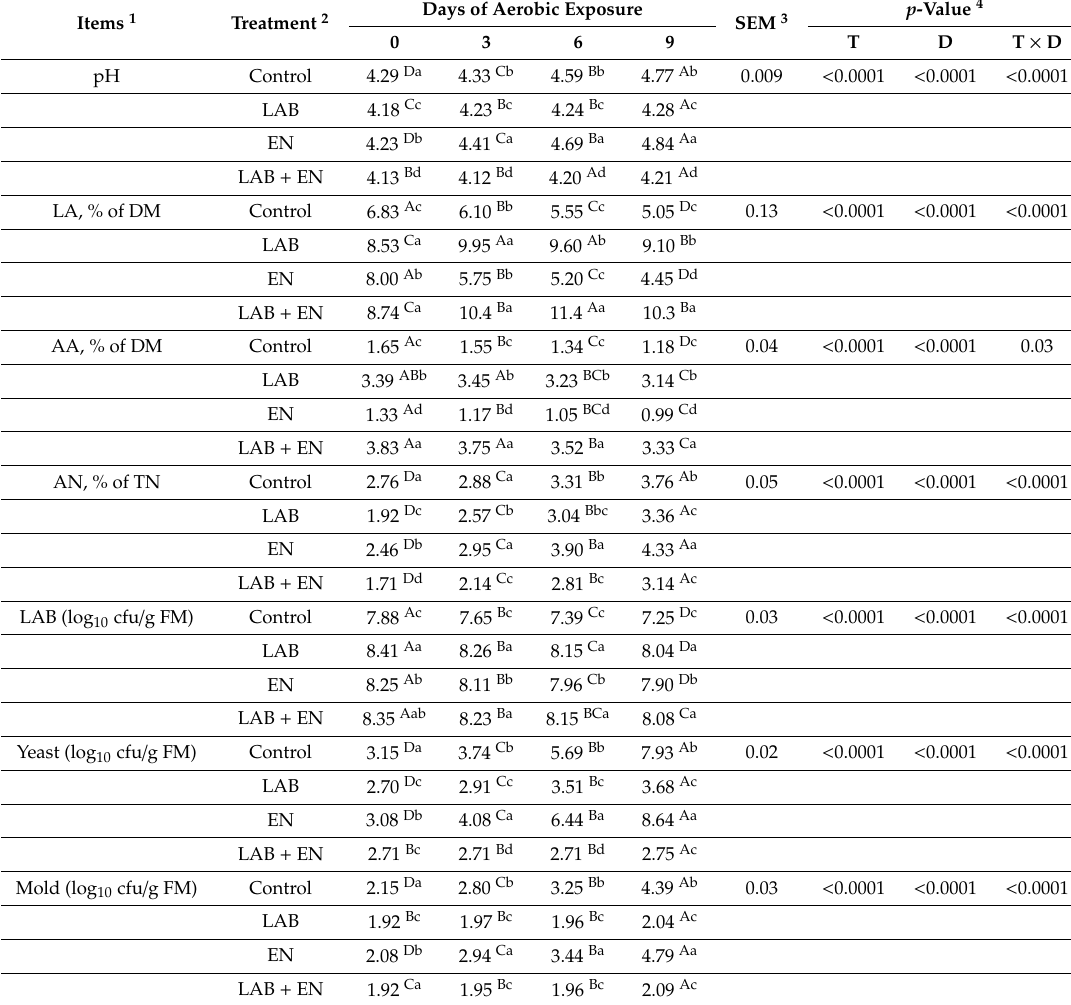
Table 5. E ff ects of lactic acid bacteria and / or fibrolytic enzyme on the fermentative characteristics of the total mixed ration silages containing wet corn gluten feed and corn stover during aerobic